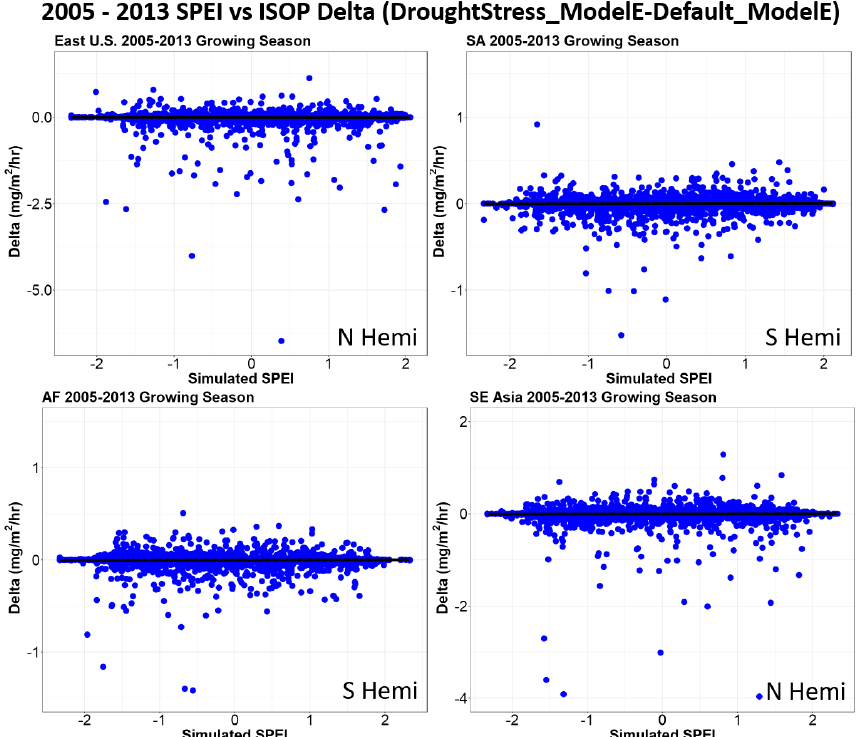
Figure 4. Scatterplots of four global isoprene hotspots and their relative differences in isoprene emissions (mgm − 2 h − 1 isoprene) in rela- tionship to simulated SPEI from 2005–2013 during the growing season. The four regions of focus are the eastern US (East), the Amazon (SA), central Africa (AF), and Southeast Asia (SE Asia). The regions East and SE Asia are in the Northern Hemisphere, and the growing sea- sons is from March–October. The hotspots of SA and AF are in the Southern Hemisphere, and the growing season is during spring–summer